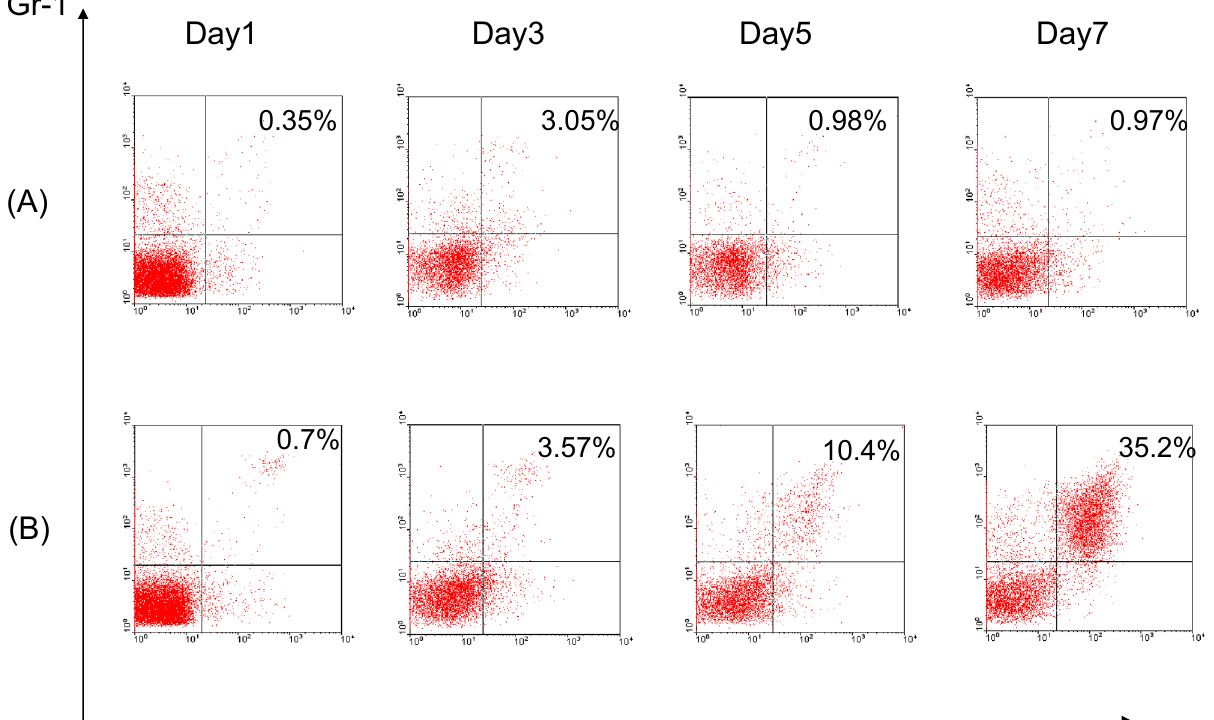
Figure 2. Representative MDSCs expanded by the conditional medium. Naïve spleen cells were cultured in ( A ) RPMI 1640 with 10% FCS and ( B ) conditional medium collected from Hepa1-6 cell culture. Gr-1 + CD11b + cells were increased beginning on day 5 and were very prevalent by day 7 when the cells were cultured in conditional